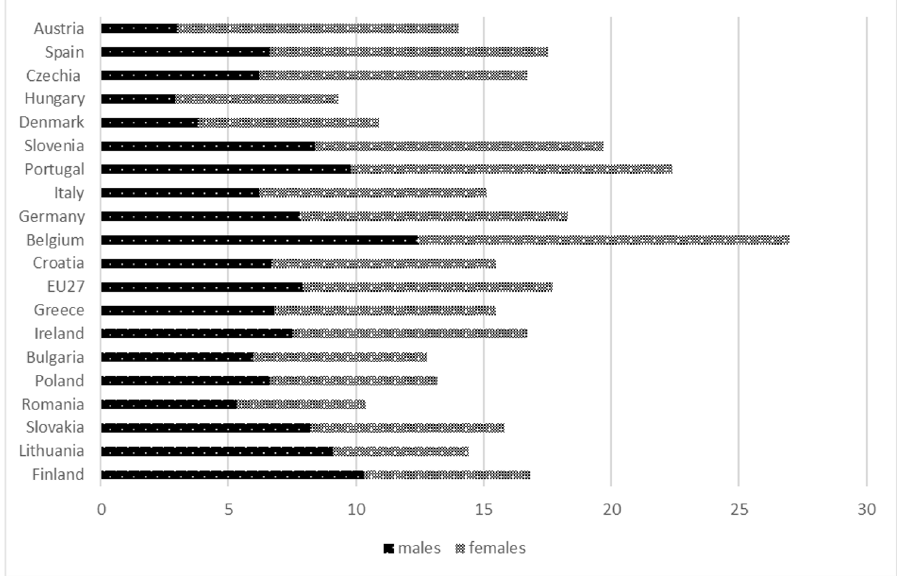
Figure 5. Difficulties in concentration on job because of family